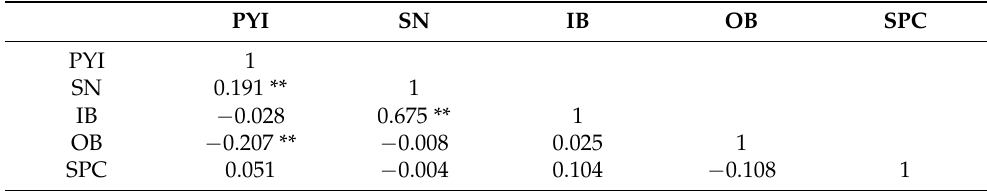
Table 5. Pearson Correlation